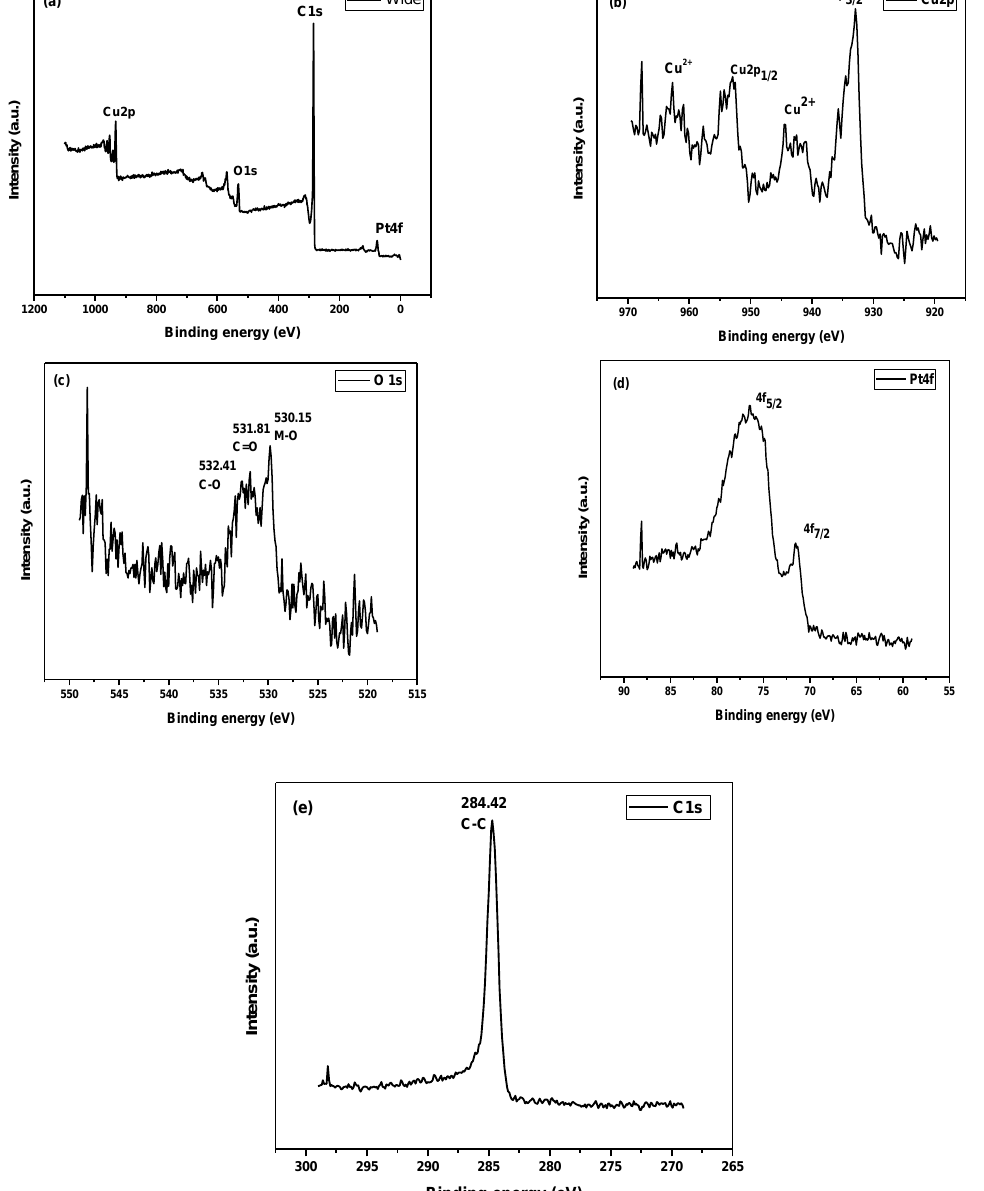
Figure 6. ( a ) XPS wide spectrum of CuPt / NC and individual XPS scans of ( b ) Cu2p, ( c ) O1s, ( d ) Pt4f, ( e ) C1s.